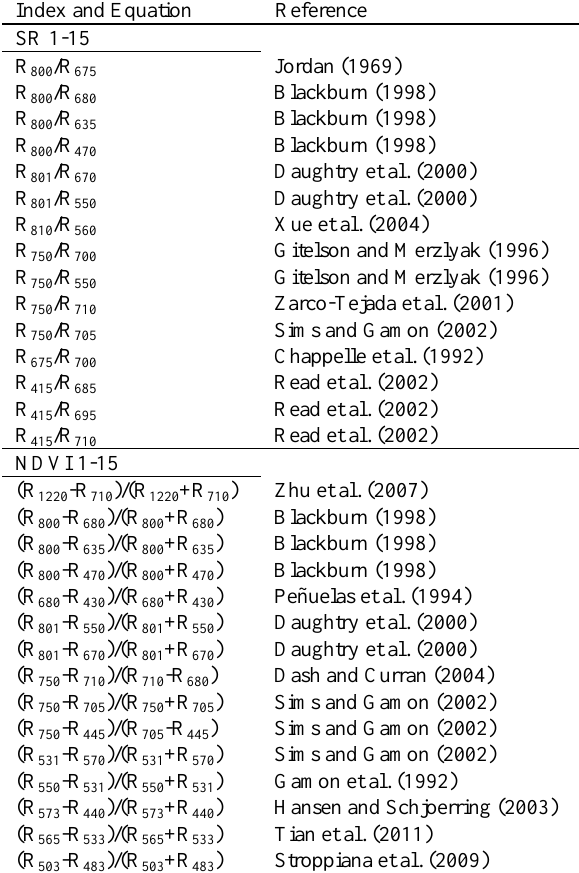
Table 1. Published VIs evaluated in this study.